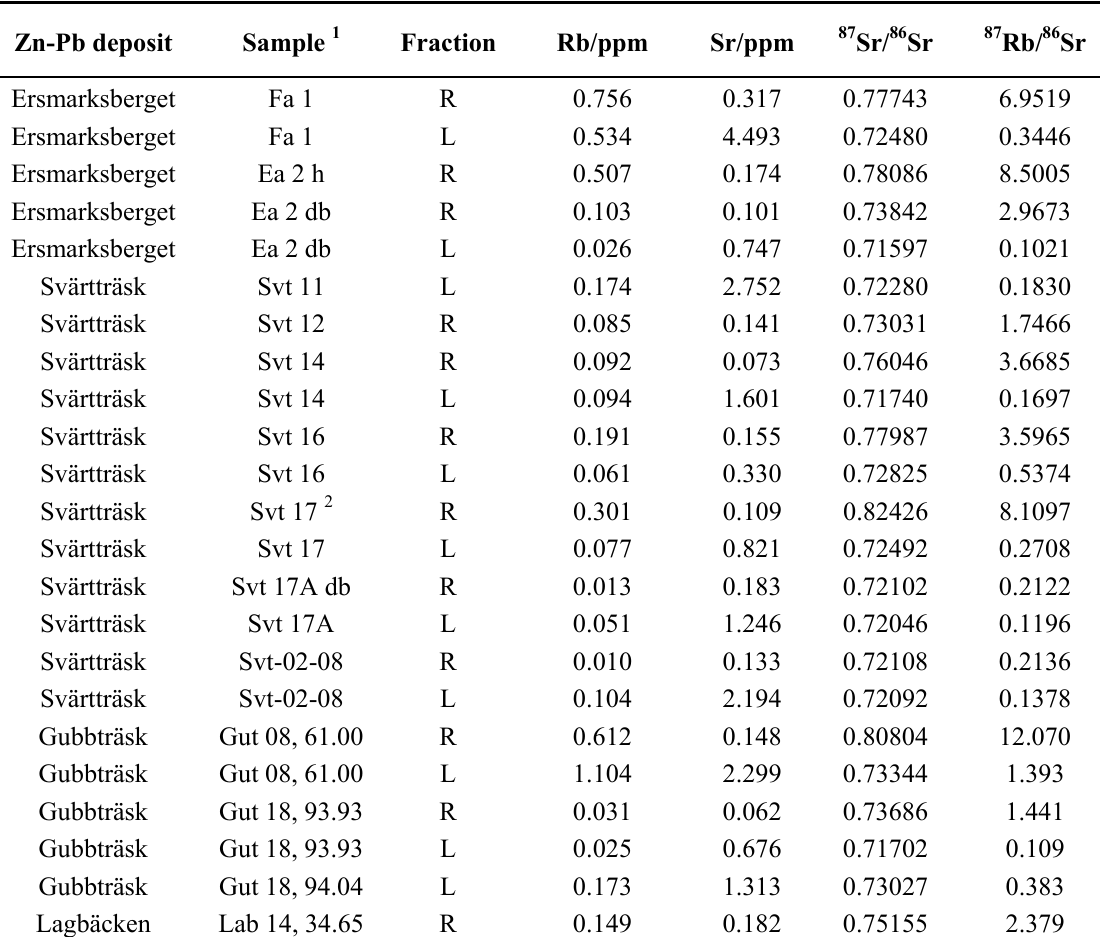
Table 3. Rb-Sr data of sphalerite samples, separated into a residual (R) and a leachate (L) fraction. Also included are two gangue minerals from